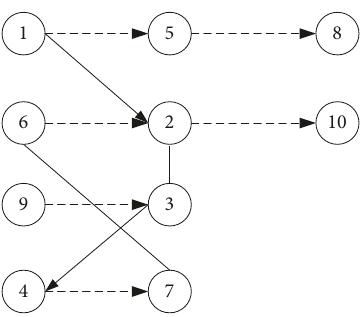
Figure 13: Topological diagram for the scheduling of block trans- portation tasks ( 𝑛 =10).